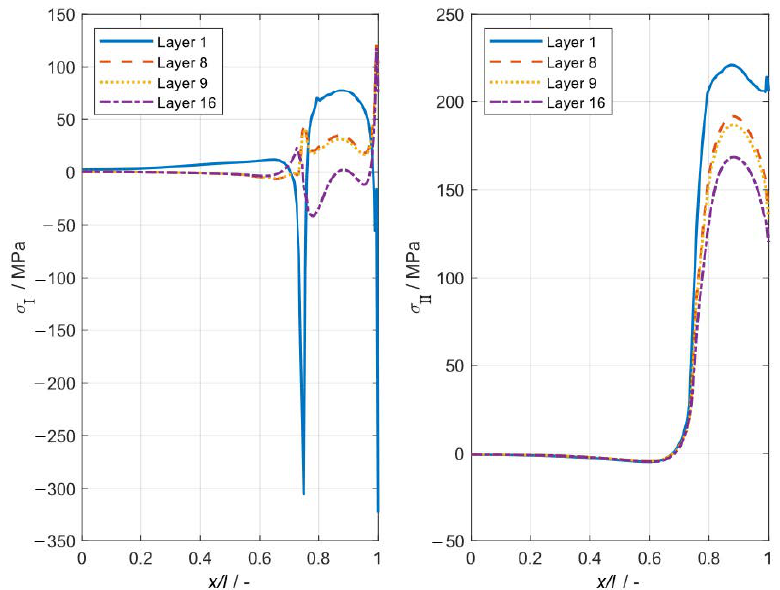
Figure 8. Longitudinal and transverse residual stresses along the x-direction in +45° layers at the specimen center y = 0.5 w .